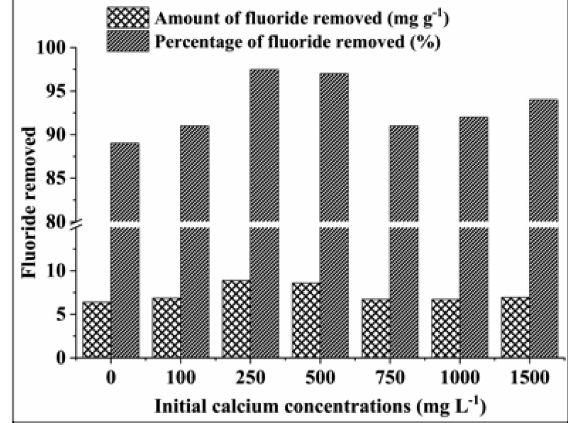
Figure 8. The amount and percentage of fluoride removal in the presence of calcium (initial fluoride level: 15 mg L − 1 ).